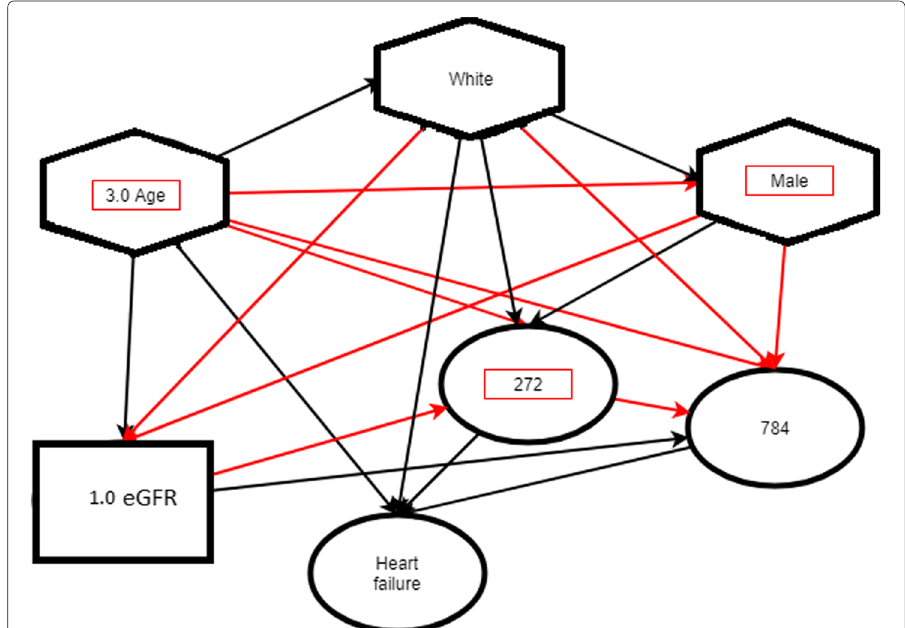
Fig. 2 Above is an example of a patient network which contains demographic information, lab results, and diagnoses codes, for a patient who develops heart failure as a fast progressor. The most significant edges and nodes, as determined by the two-sided Z-test, marked in red, are used in patient risk calculation. Circles represent ICD diagnoses, hexagons demographic information, and squares clinical variables. Age and clinical variables had been quartiled such that 3.0 Age represents a patient whose age is in the top 75 percent of patients, and where 1.0 eGFR represents someone whose eGFR is between 25-50 percent when compared to the patient population